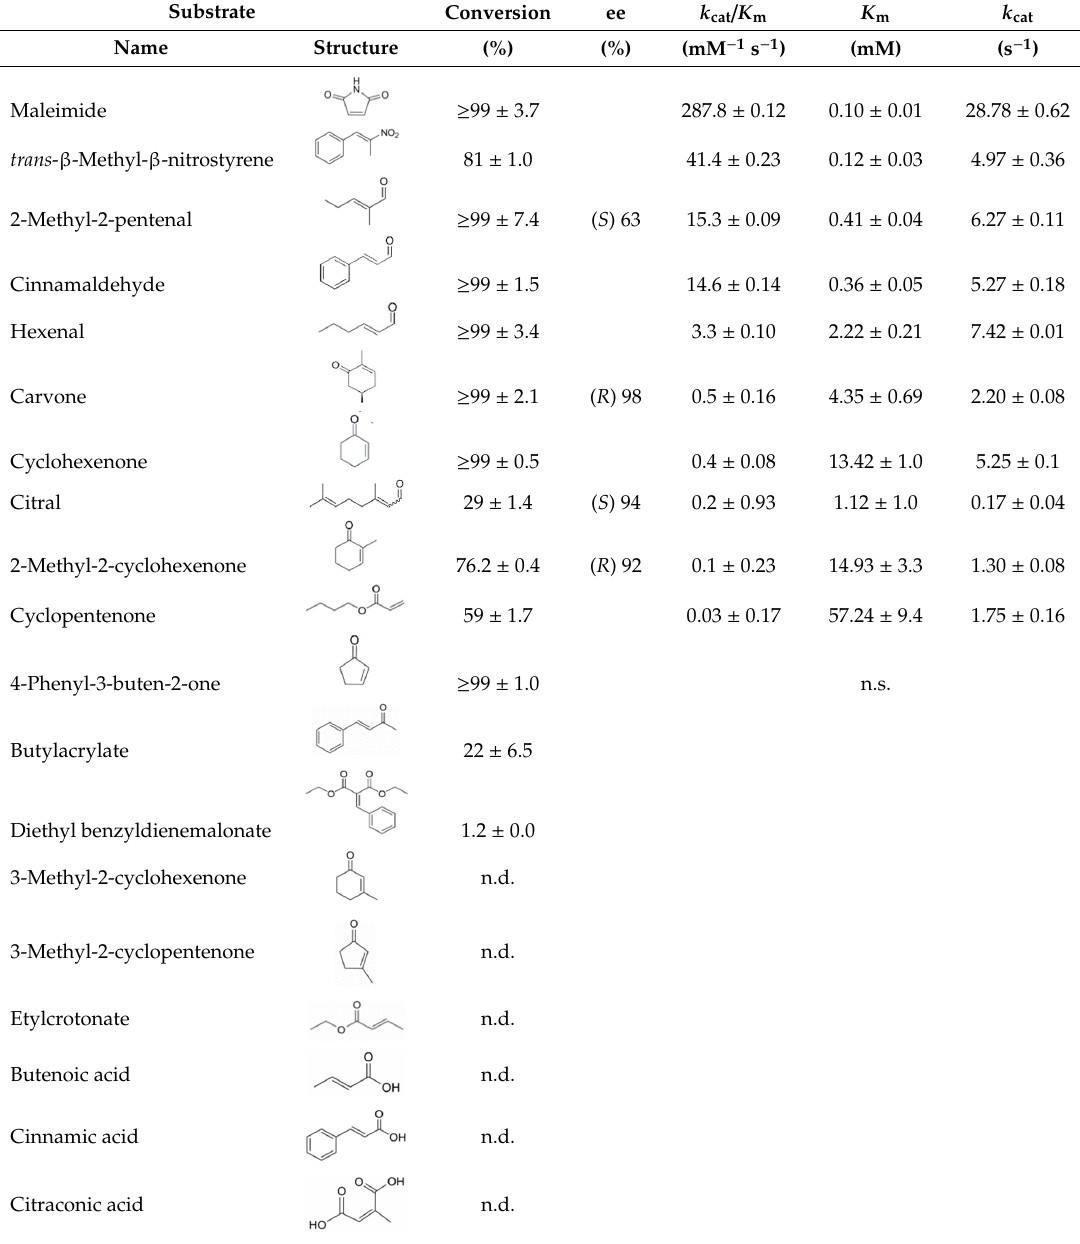
Table 1. Conversion, steady state kinetics, (a) and enantiomeric excess (ee) of various substrates converted with purified enzymes as determined after 4 h at 20 °C (n.d.: not detected; n.s.: not soluble). The given uncertainties show the standard deviation of triplicates.